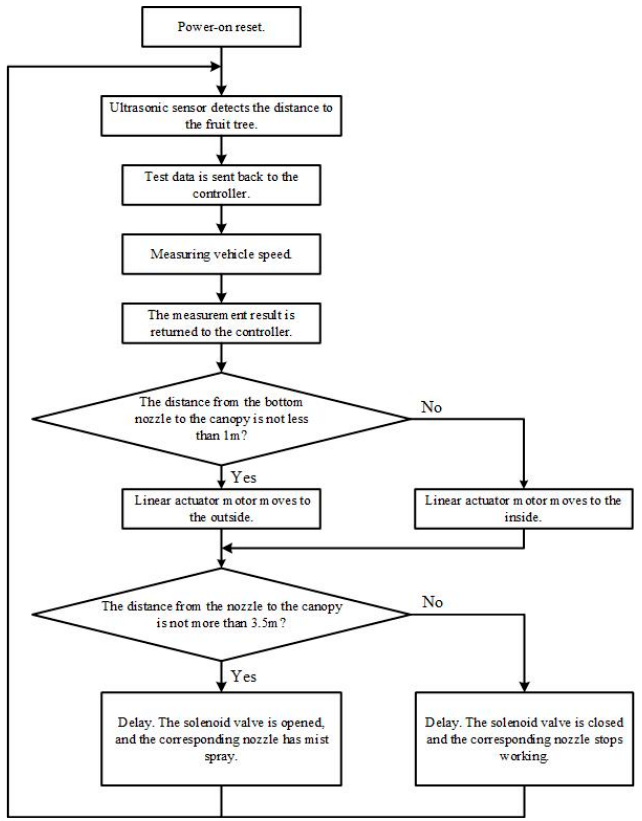
Figure 9. System control scheme.